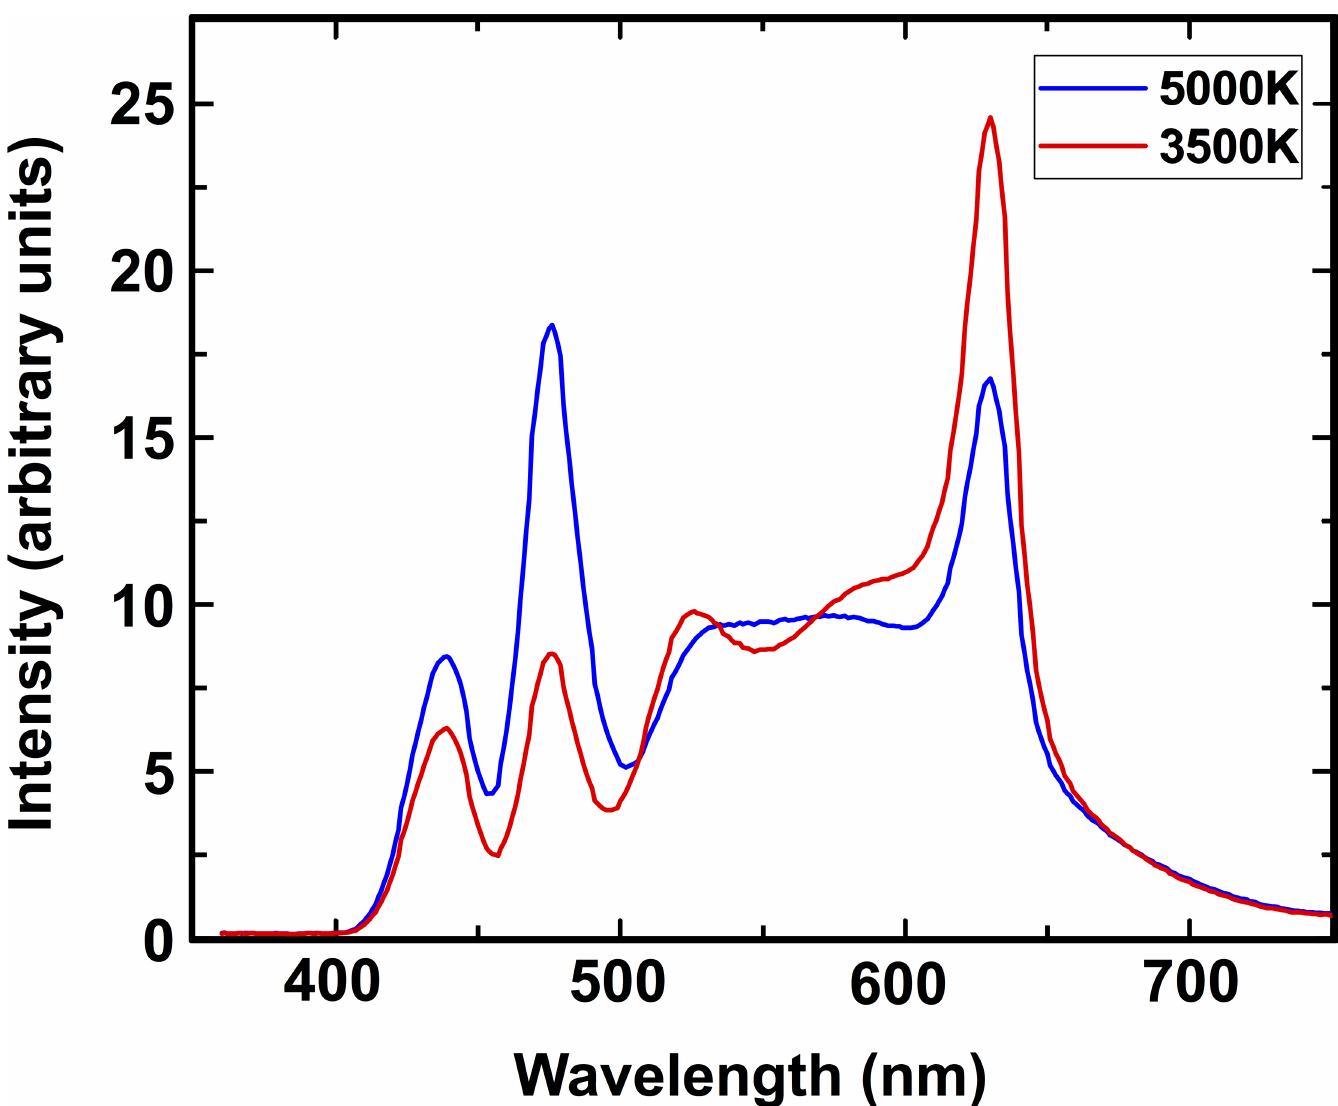
Fig 1. Spectra of the room lights at 3500K and 5000K measured at the source.